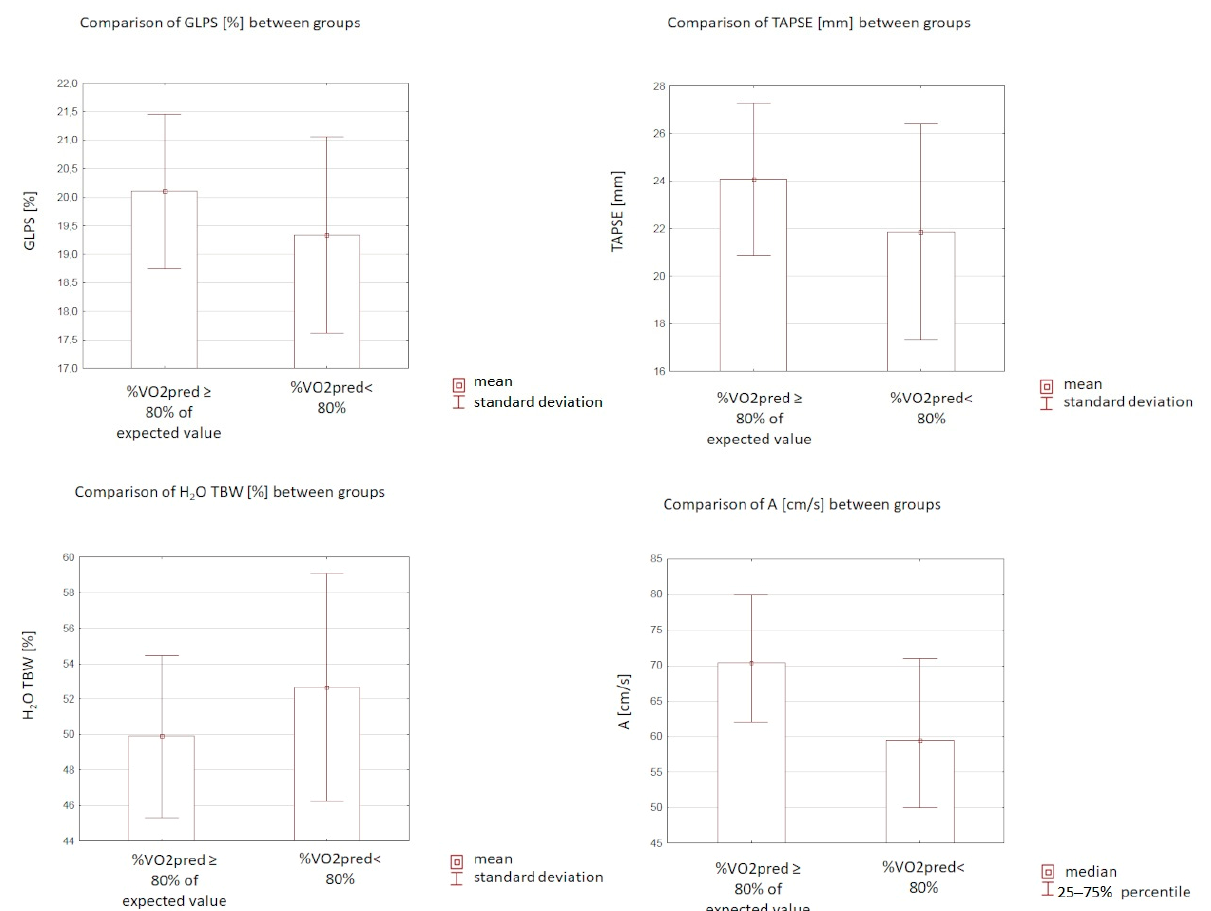
Figure 1. Comparison of selected echocardiographic and body mass analysis parameters between the investigated groups. %VO 2 pred — percentage predicted oxygen uptake at peak exercise; GLPS — global peak systolic strain; TAPSE — tricuspid annular plane systolic excursion; A — late diastolic filling velocity; H 2 O TBW — total body water.